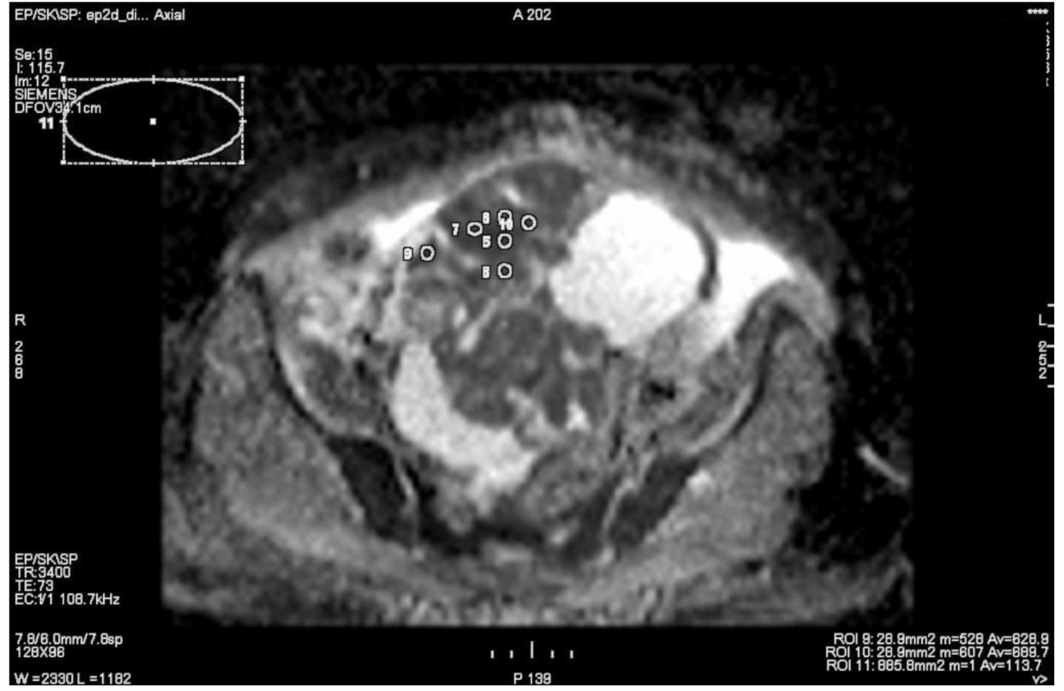
Figure 9. Images from a 60-year-old woman with high grade ovarian cancer. A large primary cystic tumor inspection for solid components. Diffusion-ADC maps. Multiple small ROI are placed on the solid part of the